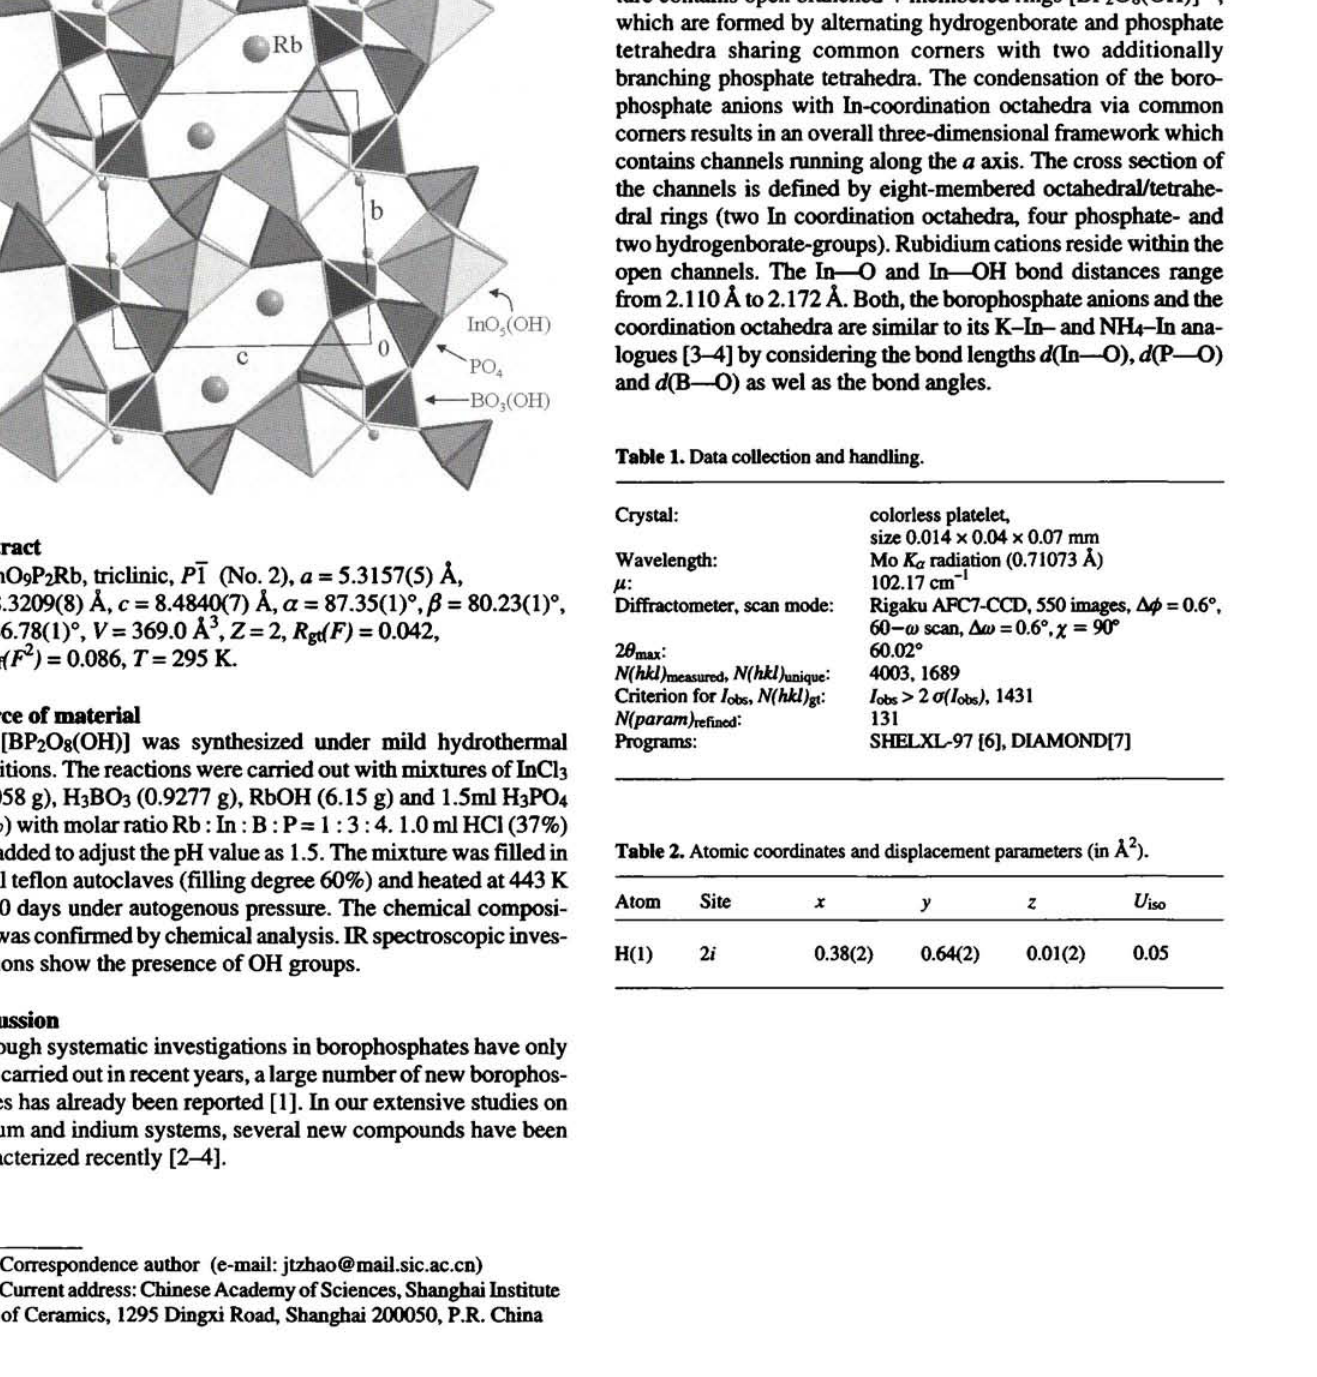
Table 2. Atomic coordinates and displacement parameters (in Â 2